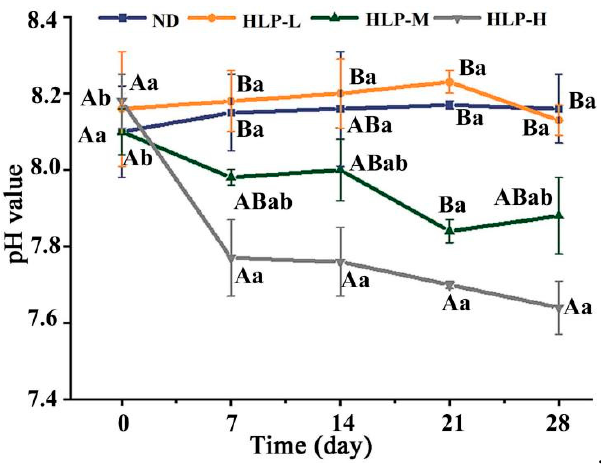
Figure 1. Changes in pH values in the mouse feces among different groups. The different uppercase and lowercase letters around the points represent significant differences in various groups and times (day), respectively ( p < 0.05). Table 1. Changes in total sugar, reducing sugar and free monosaccharide contents for in-vitro fermentation.